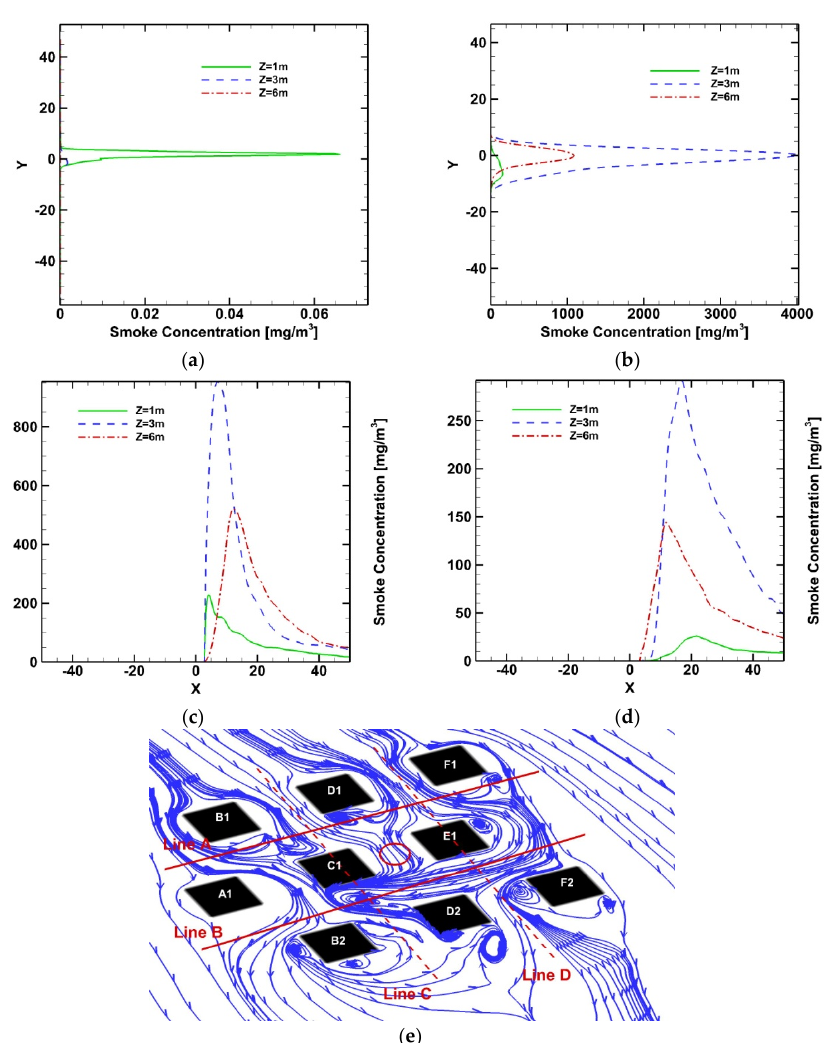
Figure 8. Smoke average concentration distribution along ( a ) line A; ( b ) line B; ( c ) line C; ( d ) line D for Case 1 and ( e ) the streamlines that define it.